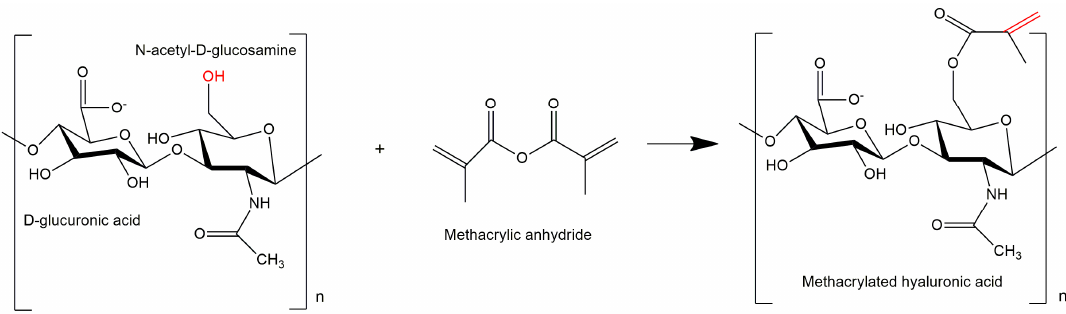
Figure 1. Modification of hyaluronic acid using methacrylic anhydride.